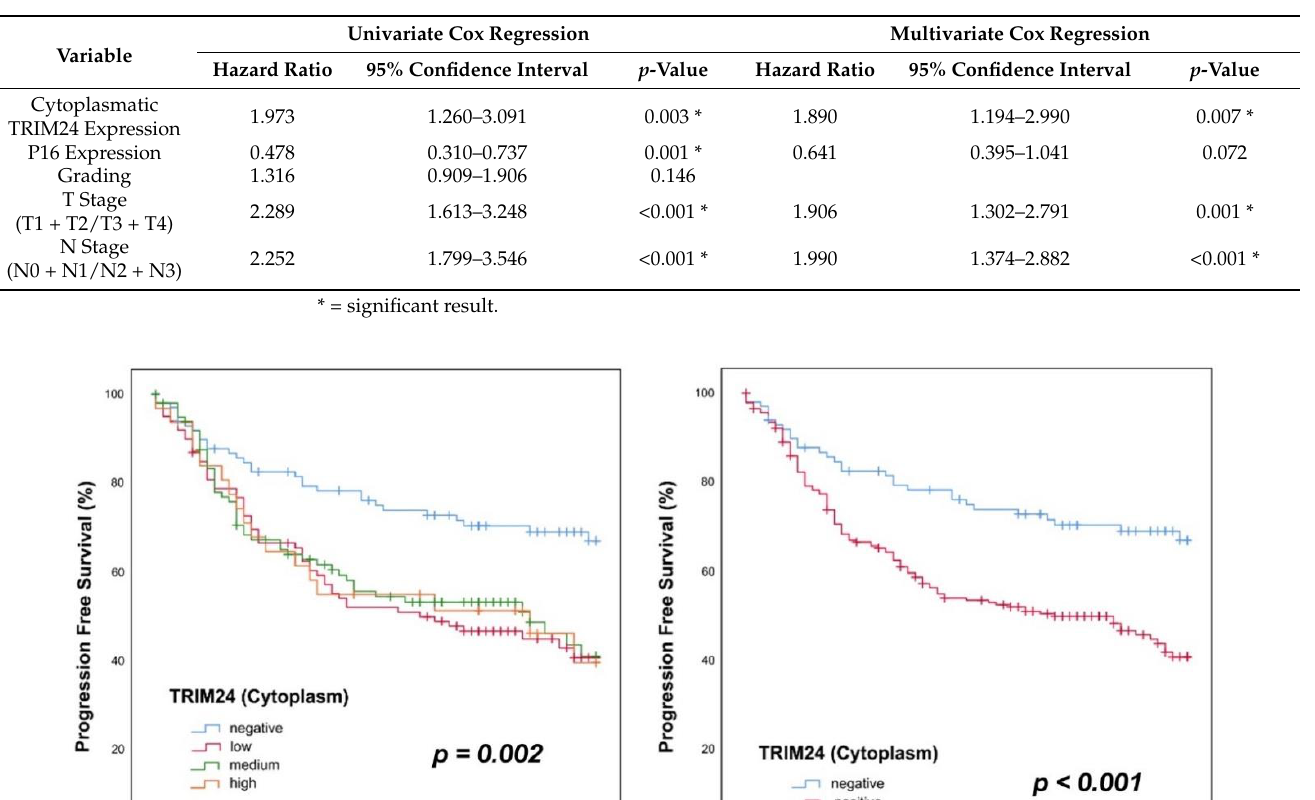
Table 1. Univariate and multivariate cox regression for 60-months OS.